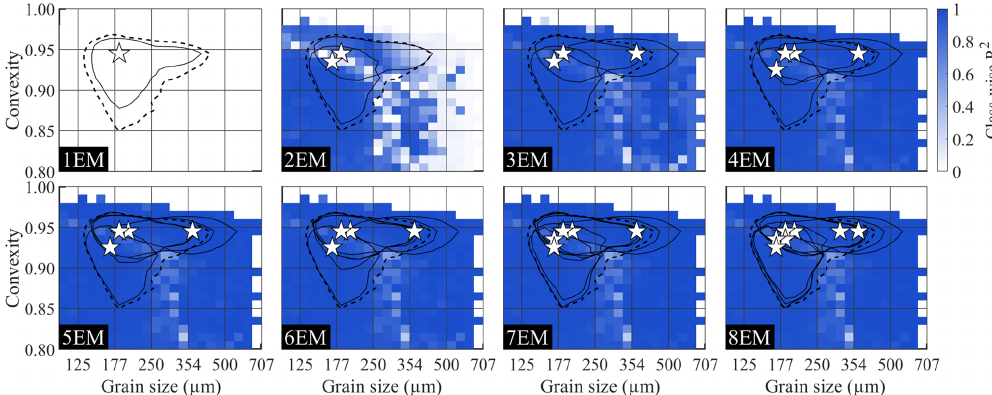
Figure 7. Class-wise R 2 distributions for endmember modelling results of the ConD2d 4EM_noise_highmix dataset. All solutions up to eight endmembers are shown. Solid black lines denote endmember contours: lines drawn along those size–shape classes where the volume of the endmember SSD equals 0.5%. The median SSD of the dataset (average SSD) is represented by a dashed line at 0.2% volume. White stars denote the modes of the endmember size–shape distributions.